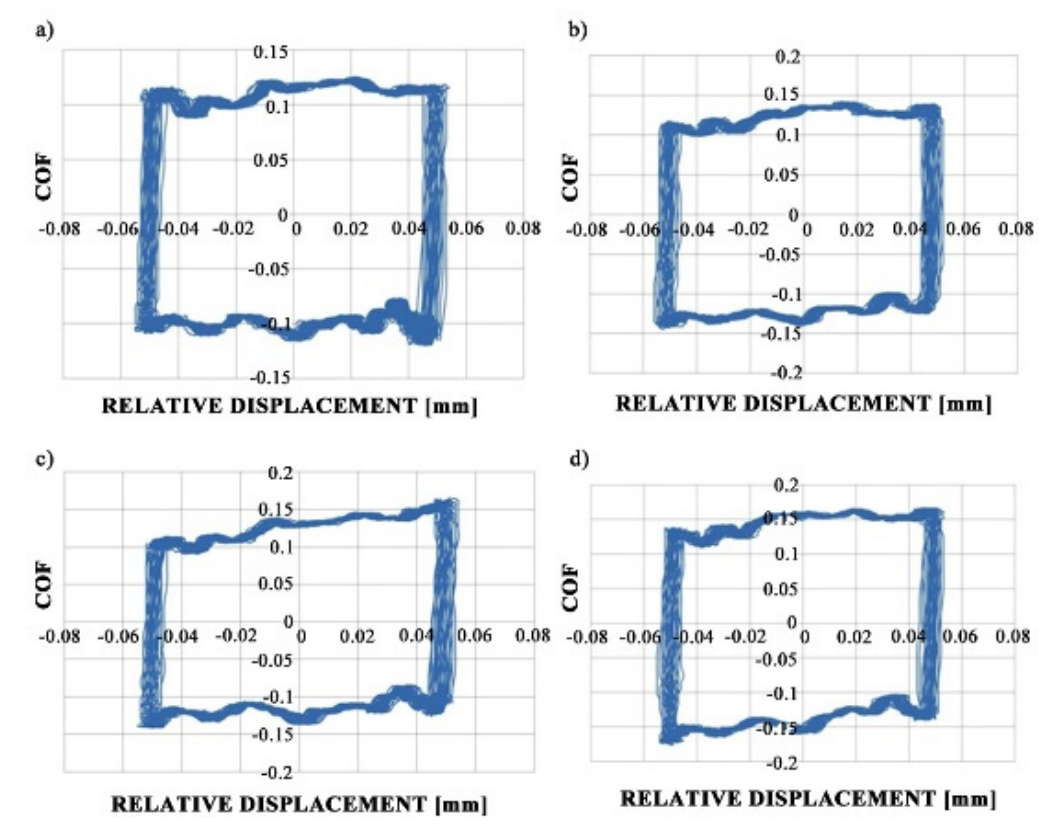
Figure 7. Fretting loops for assemblies with M1 ( a , c ) and VB1 discs ( b , d ) during tests A ( a , b ) and B ( c , d ).